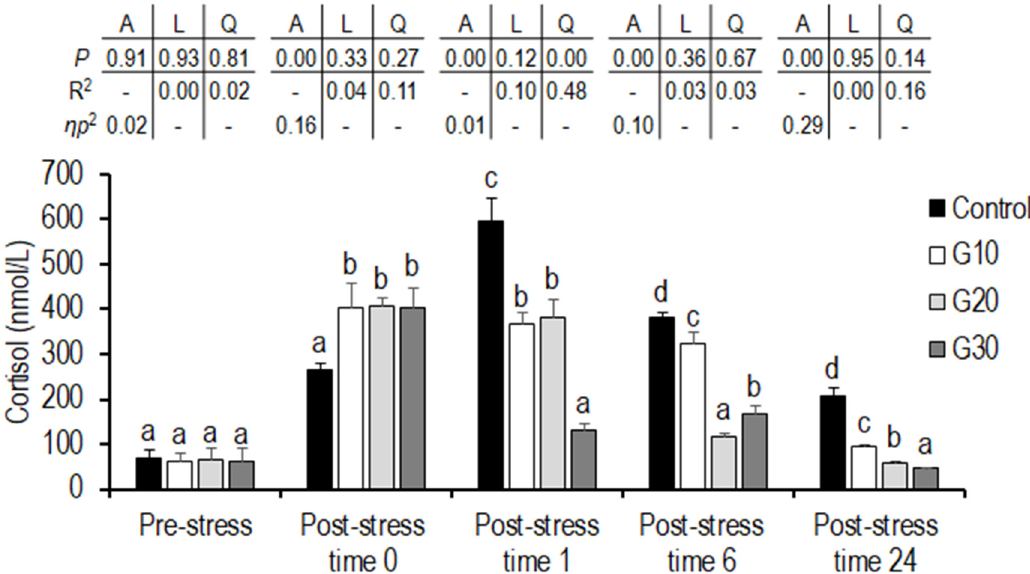
Figure 1. Serum cortisol of Eurasian perch provided feed supplemented with garlic powder under high-density and net handling stress. Values are presented as (mean ± SD; n = 6 ). Mean values with different superscripts within each time vary significantly according to one-way ANOVA ( p < 0.05). A = the variance analysed by one-way ANOVA; L = the linear trend analysed by orthogonal polynomial contrasts; Q = the quadratic trend analysed by orthogonal polynomial contrasts. R 2 = R square. ƞ p2 = partial eta squared. Control: without garlic supplement; G1: 10 g garlic powder per 1000 g diet; G2: 20 g garlic powder per 1000 g diet; G3: 30 g garlic powder per 1000 g diet. Pre-stress: before stress; Post-stress time 0: immediately after stress; Post-stress time 1: one hour after stress; Post-stress time 6: 6 h after stress; Post-stress time 24: 24 h after stress.